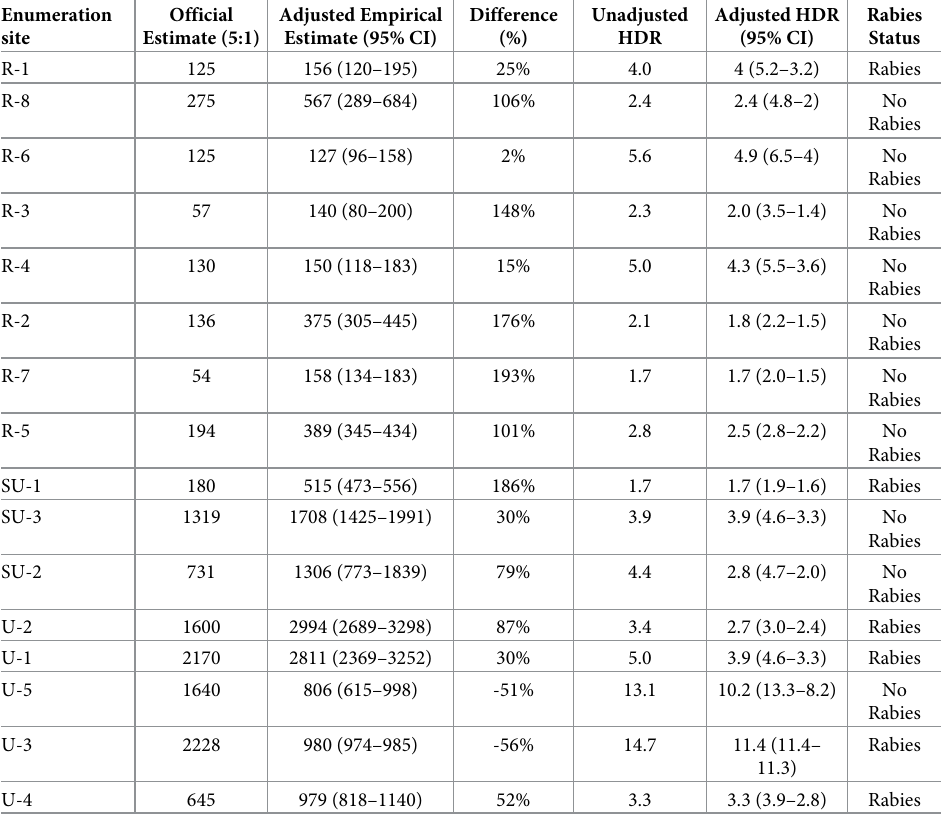
Table 4. Differences between the official, unadjusted and adjusted human to dog ratio amongst the study sites– Guatemala, March—July 2018. Enumeration